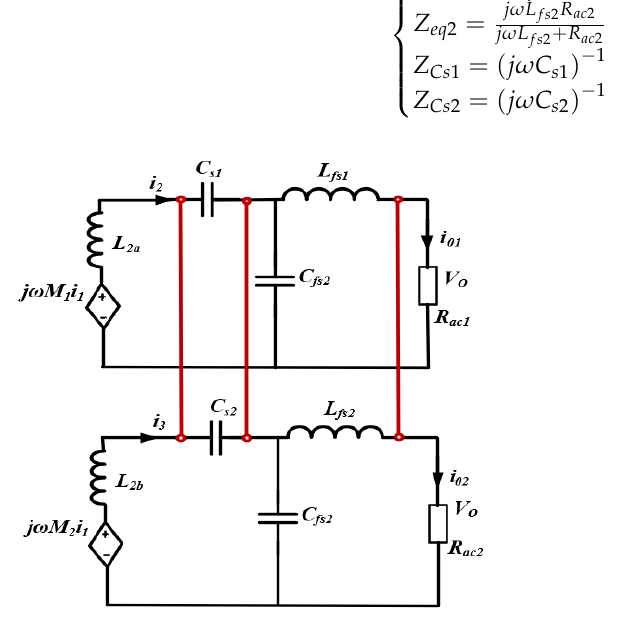
Figure 25. AC equivalent circuit of LCC-LCC BP receiver with passive balancing configuration.